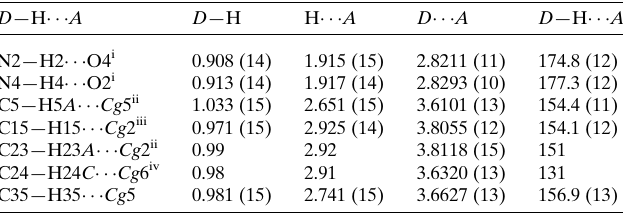
Table 1 Hydrogen-bond geometry (A˚ , (cid:3) ).